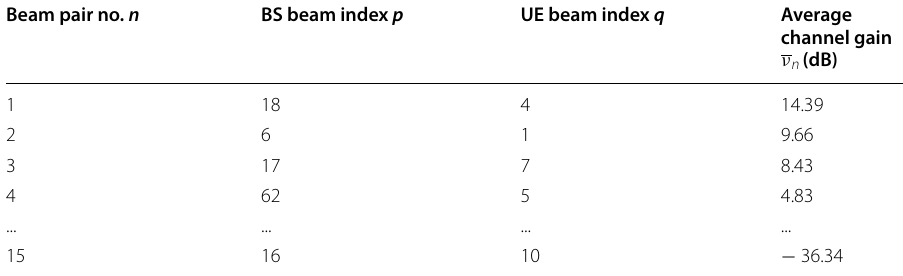
The indices p and q are the beam indices in codebooks F N TX × N TX and W N RX × N RX , respectively